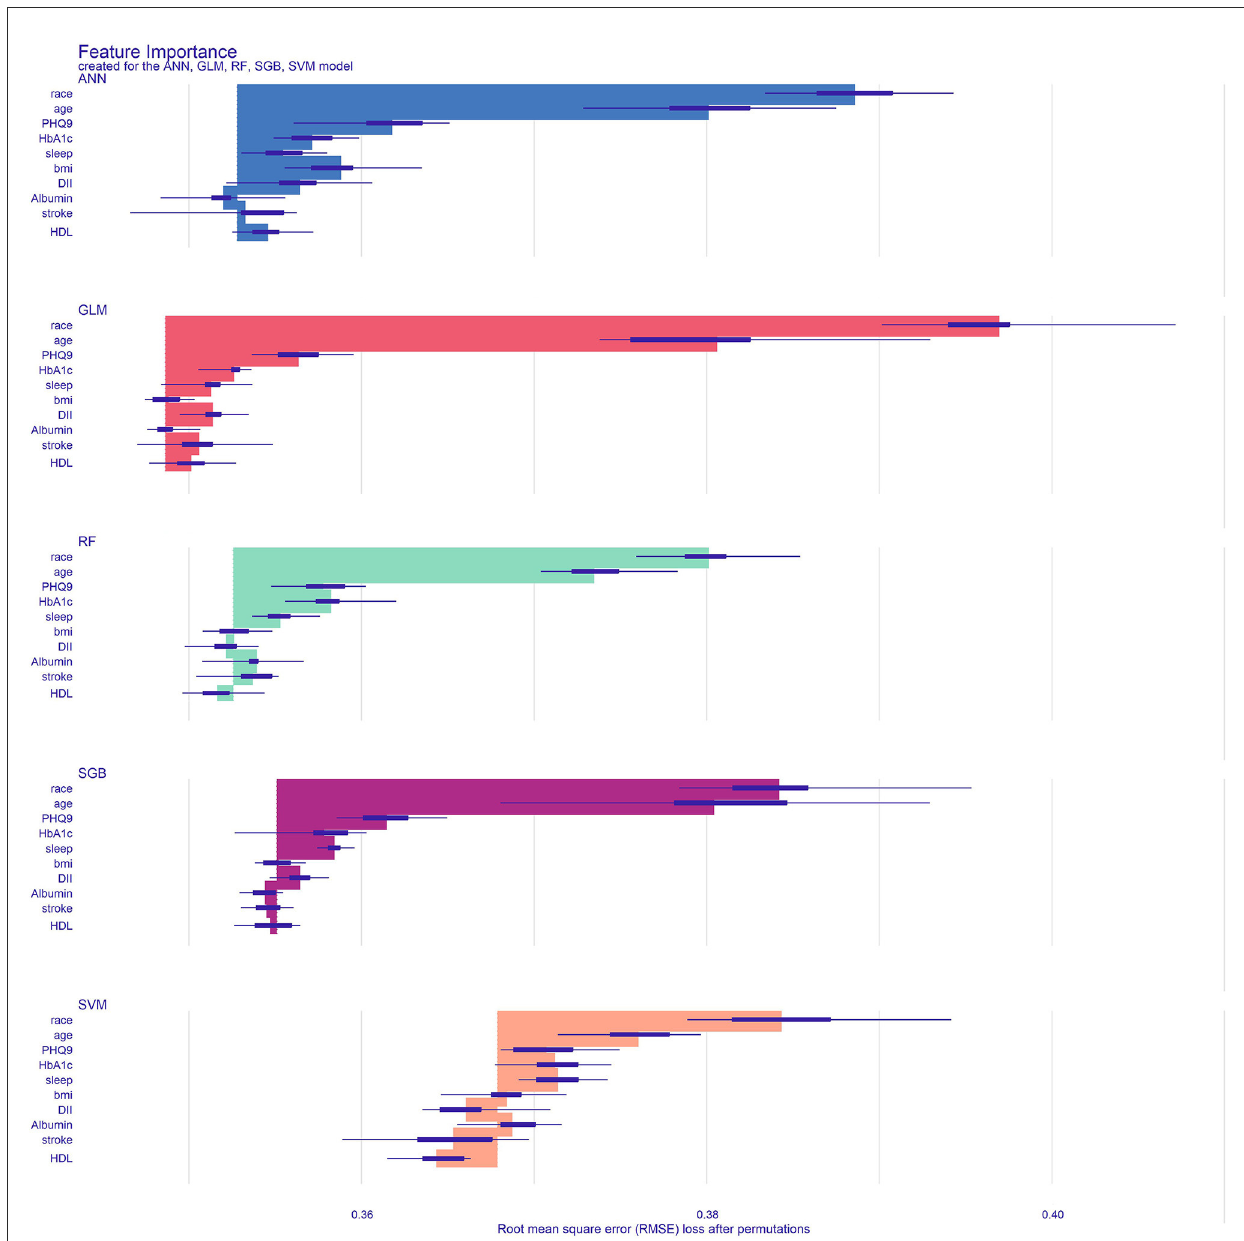
FIGURE5 Analyze and visualize the feature importance of the classification model. GLM, generalized linear model; RF, Random Forest; SVM, support vector machine; ANN, artificial neural network; SGB, Stochastic Gradient Boosting; bmi, Body mass index; stroke, ever told you had a stroke; DII, Dietary Inflammatory Index; HbA1c, glycated hemoglobin; PHQ9, Patient Health Questionnaire-9; sleep, how much sleep do you get; HDL, direct HDL-cholesterol